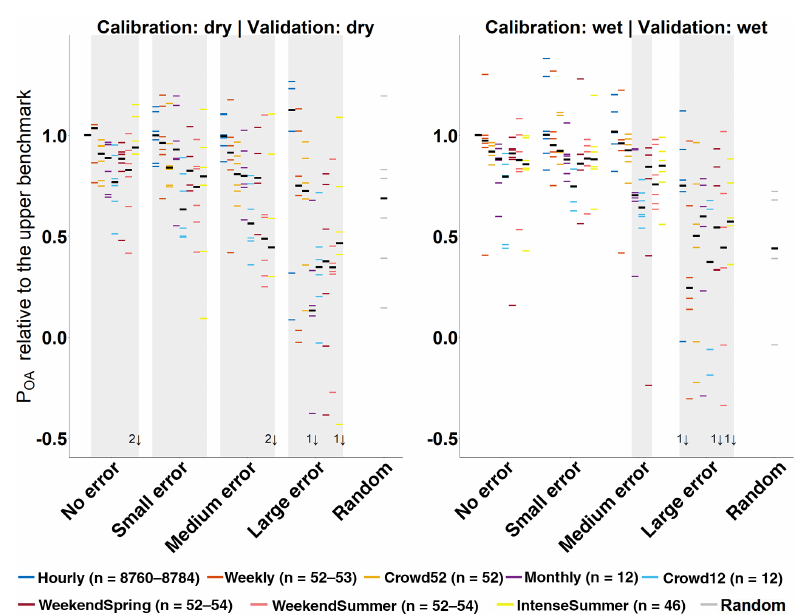
Figure 6. Median model validation performance for the datasets calibrated and validated both in a dry year and in a wet year. Each horizontal line represents the median model performance for one catchment. The black bold line represents the median for the six catchments. The grey rectangles around the boxes indicate non-significant differences in median model performance for the six catchments compared to the lower benchmark with random parameters. The numbers at the bottom indicate the number of outliers beyond the figure margins. For the individual P OA values of the upper benchmark (no error–Hourly dataset) in the different calibration and validation years, see Table